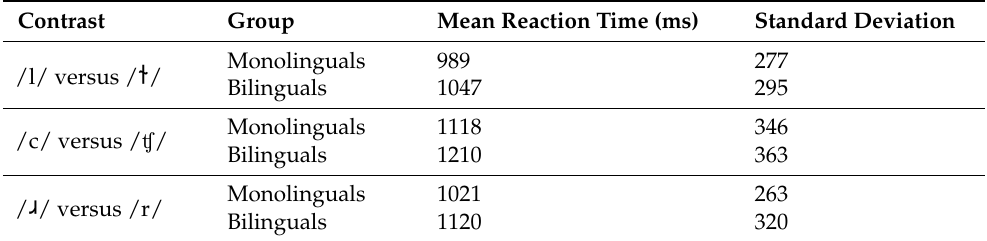
Table 8. Mean reaction times (ms) and standard deviations for each of the tested contrasts for monolinguals and